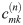
Dependence of the coefficients cmk(n) in Eq (5) on the activation frequency f, where the symbol assignment refers to the different APDn as given in the inset of the last graph, which shows the R2 values of the corresponding fits [Eq (5)].